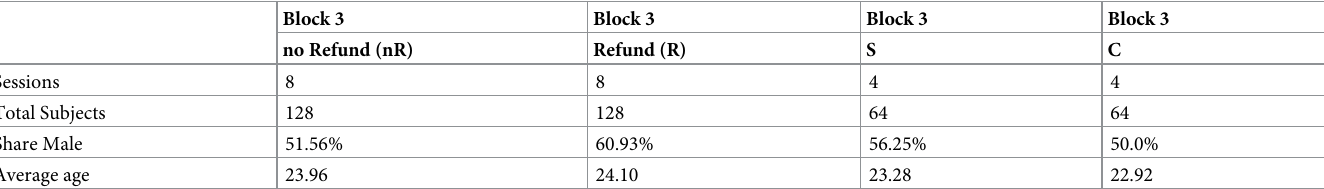
Table 2. Sample pool statistics.